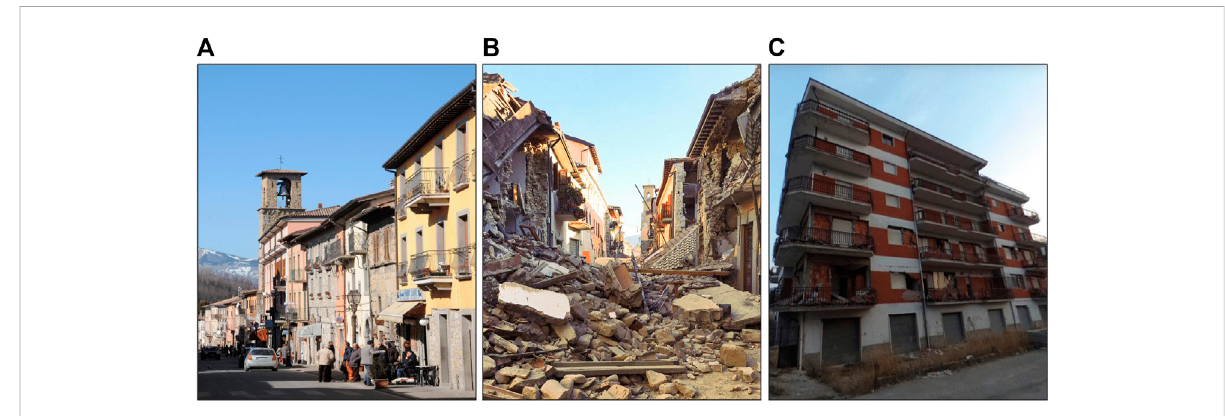
FIGURE 3 Photos of Amatrice. (A) View of the historical center of Amatrice on 26 February 2012 (Wikimedia Commons, Silvio Sorcini, licensed under CC- BY 4.0 and is available at: https://commons.wikimedia.org/wiki/File:2012-02-26_Corso_Amatrice.jpg); (B) Historical center on 29 August 2016, damaged by the M6 event of 24 August 2016 (Wikimedia Common, Diego Bianchi, licensed under CC-BY 2.0 and is available at: https://commons. wikimedia.org/wiki/File:Terremoto_centro_Italia_2016_-_Amatrice_-_corso_Umberto_I_(29242968591).jpg); (C) 5 story RC building, constructed following a low code, showing extensive damage photographed on August 31, 2017 (Mapillary, https://www.mapillary.com/, valentina_ p, licensed under CC BY SA